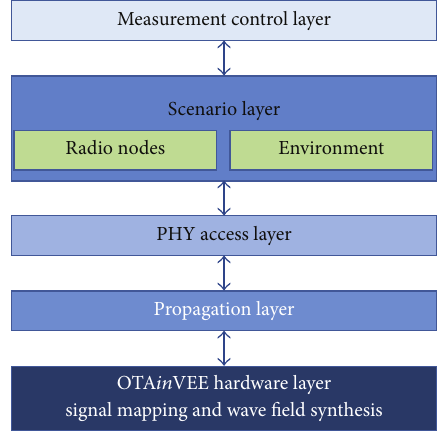
Figure 2: A layered measurement procedure for OTA emulation in a virtual electromagnetic environment (OTA in